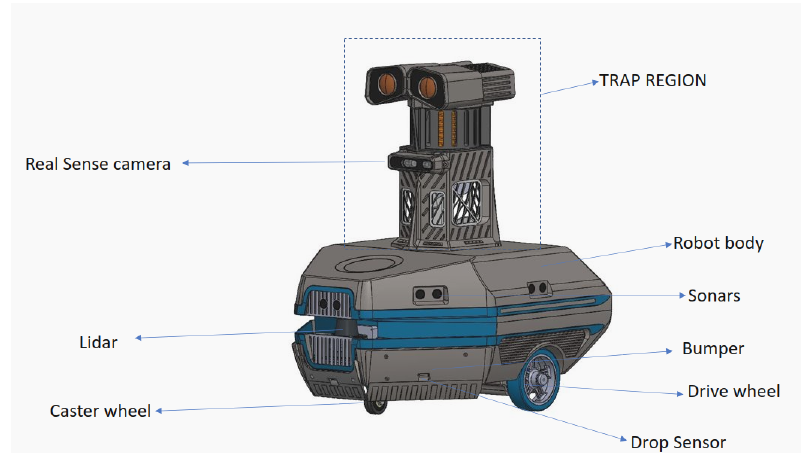
Figure 2. Dragonfly robot.